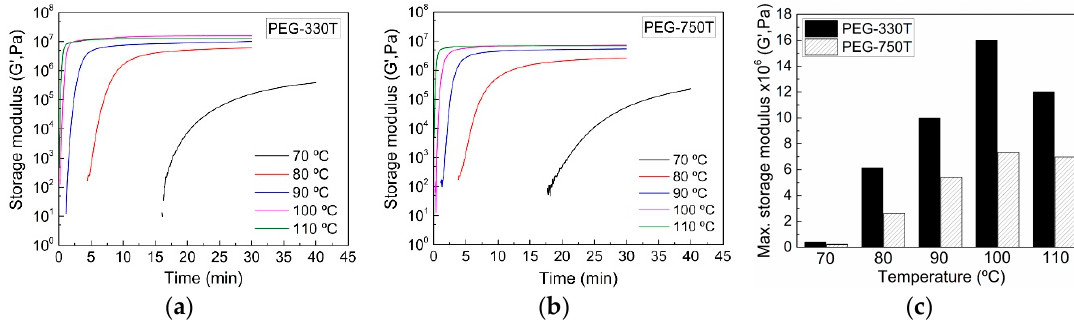
Figure 5. Real-time storage moduli for ( a ) PEG-330T and ( b ) PEG-750T mixtures during thermal curing under different temperature conditions. ( c ) Maximum G ′ data for the two hydrogel mixtures.